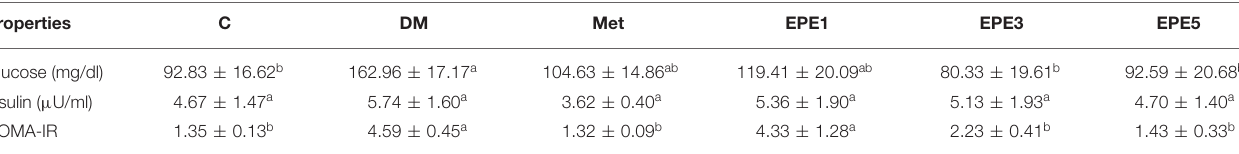
Data are shown as the mean ± SEM (n = 6). The values with different superscript letters (a, b) in the same row represent significant differences (p < 0.05) as analyzed by Duncan’s multiple range test. HOMA-IR = fasting plasma glucose (mmol/L) × fasting plasma insulin ( µ U/ml)/22.5. C, control; DM, diabetes mellitus; Met, metformin; EPE, Echinacea purpurea ethanol